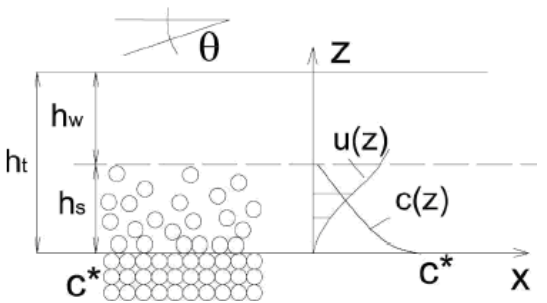
Fig. 1. Sketch of the moving layer depth h s of a flow over an erodi- ble bed. Profiles for velocity u(z) and sediment concentration c(z) (Egashira and Ashida, 1992). Figure 1. Sketch of the moving layer depth h velocity u(z) and sediment concentration c(z) (Egashira and Ashida, 1992).